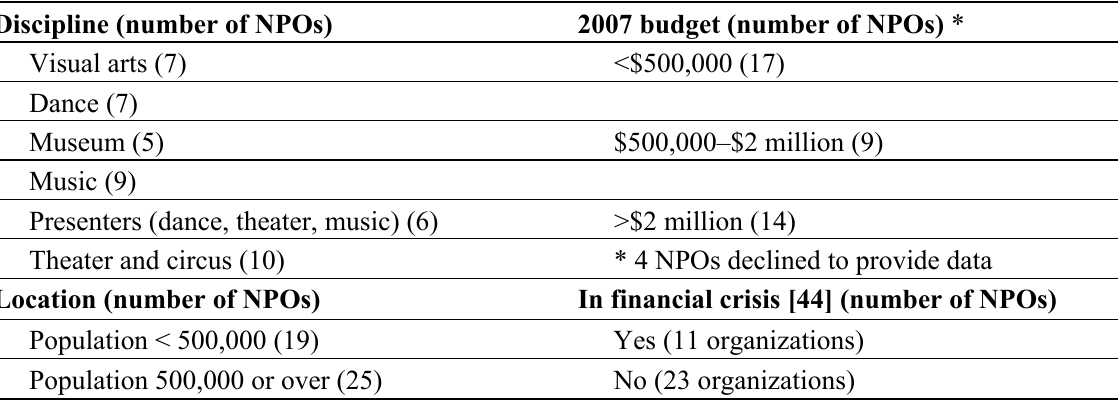
Table 2. Description of sample (four descriptive